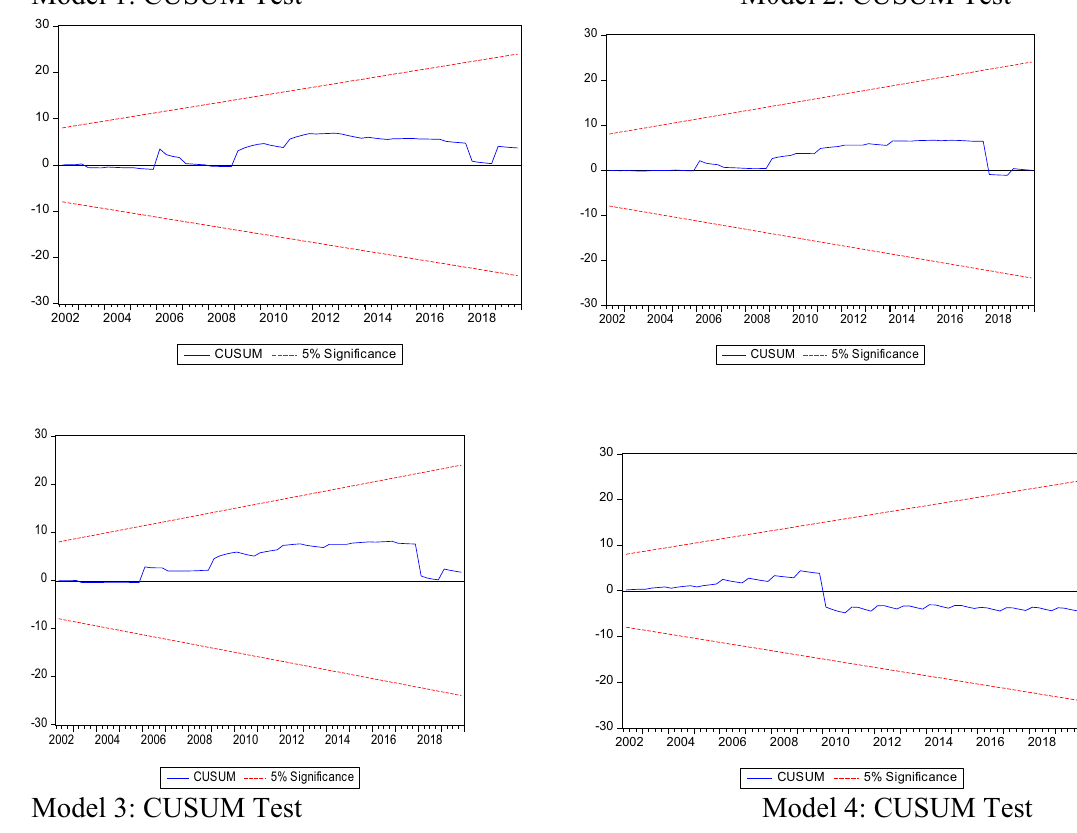
Fig. 3 CUSUM test. CUSUM test for